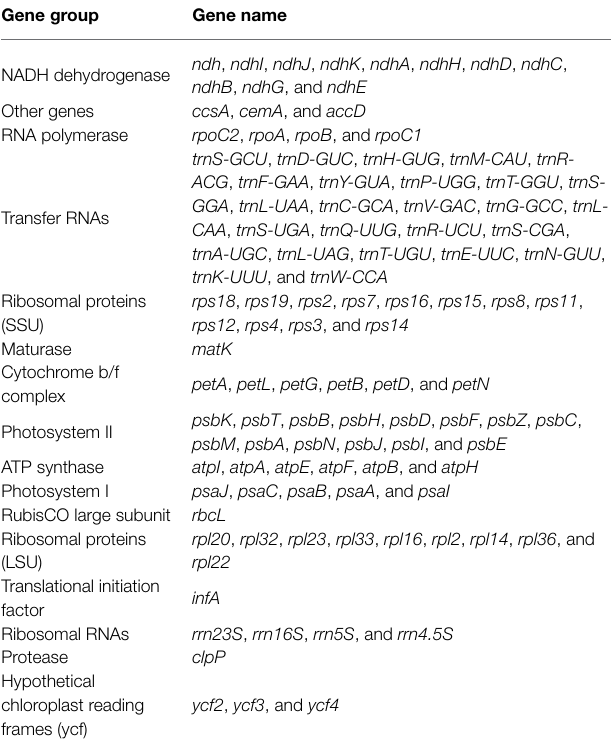
TABLE 3 | List of genes in the E. breviscapus cp genome.